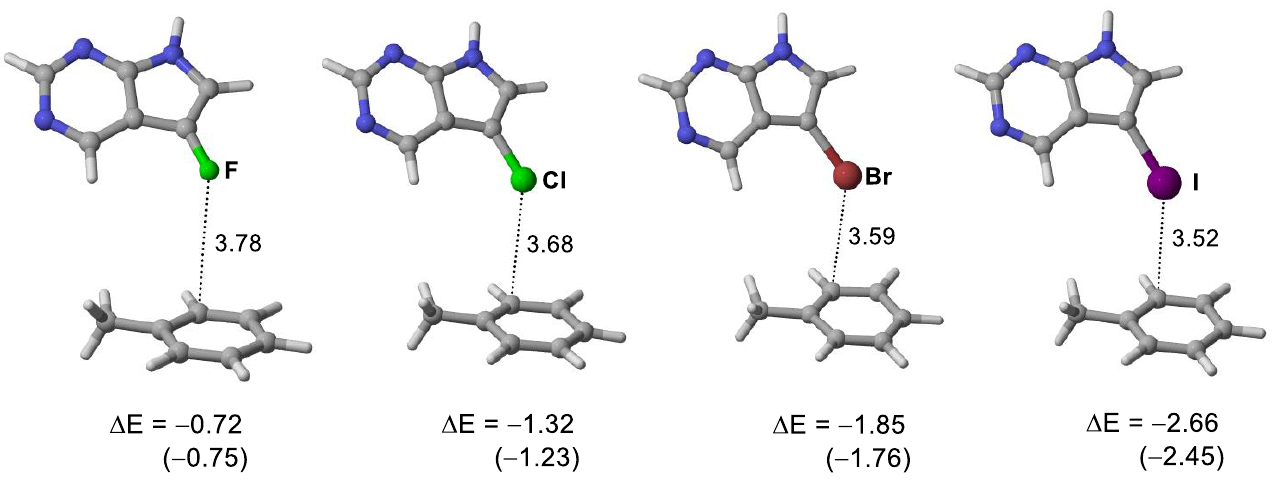
Figure 6. Structures and interaction energies ( Δ E, kcal/mol) of modeled halogen bonded complexes. Calculated interaction energies in a dielectric medium of ε = 6 are given in parenthesis.